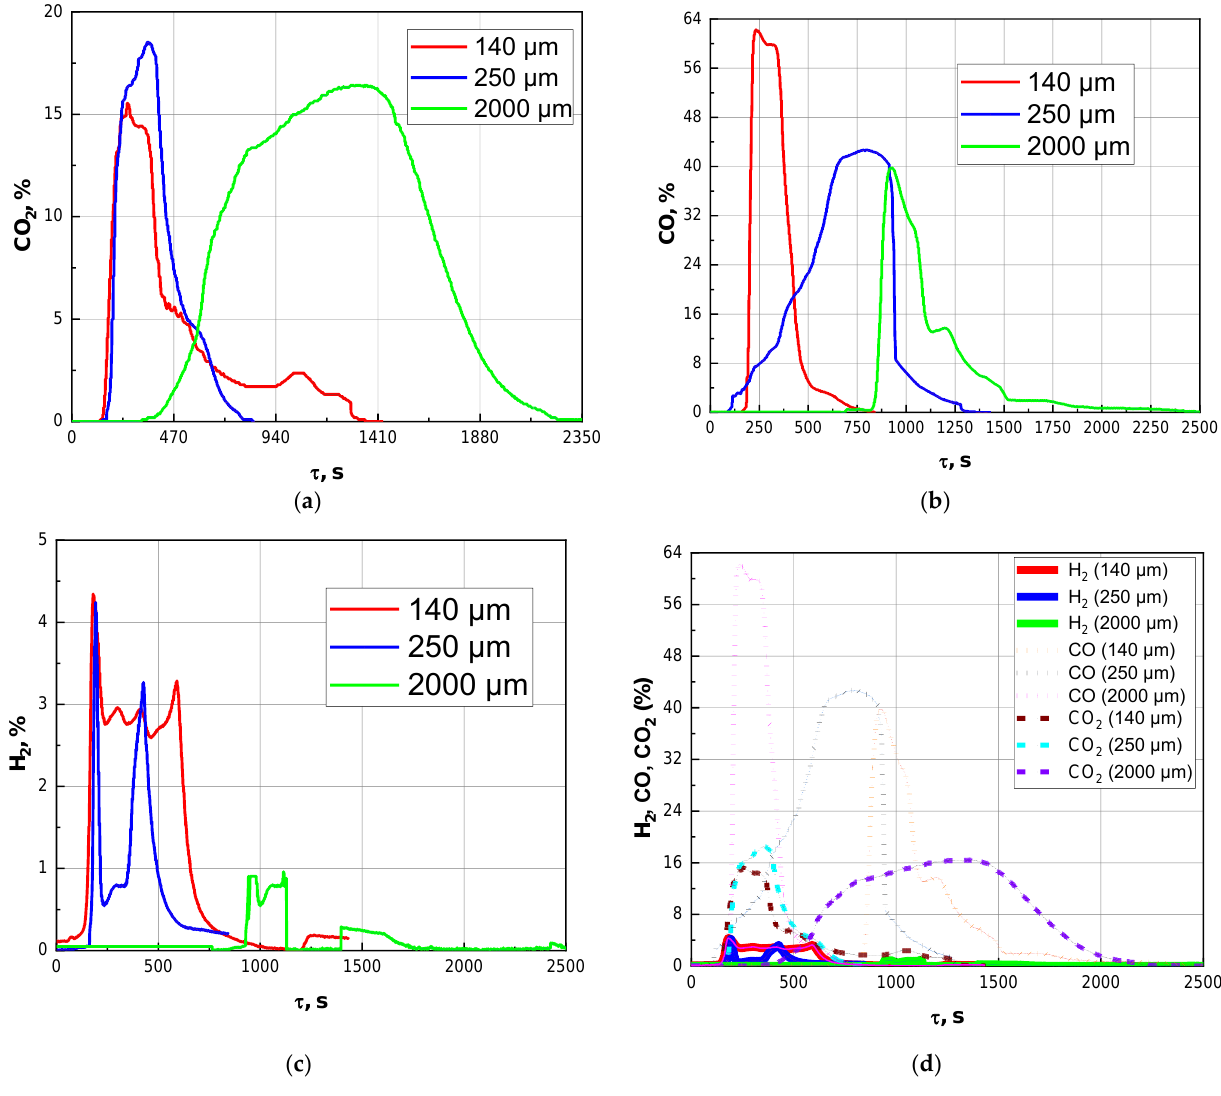
Figure 18. Trends of the concentrations of gas mixture components when varying the average particle size: CO 2 ( a ); CO ( b ); H 2 ( c ); a comparison of individual concentration trends ( d ).